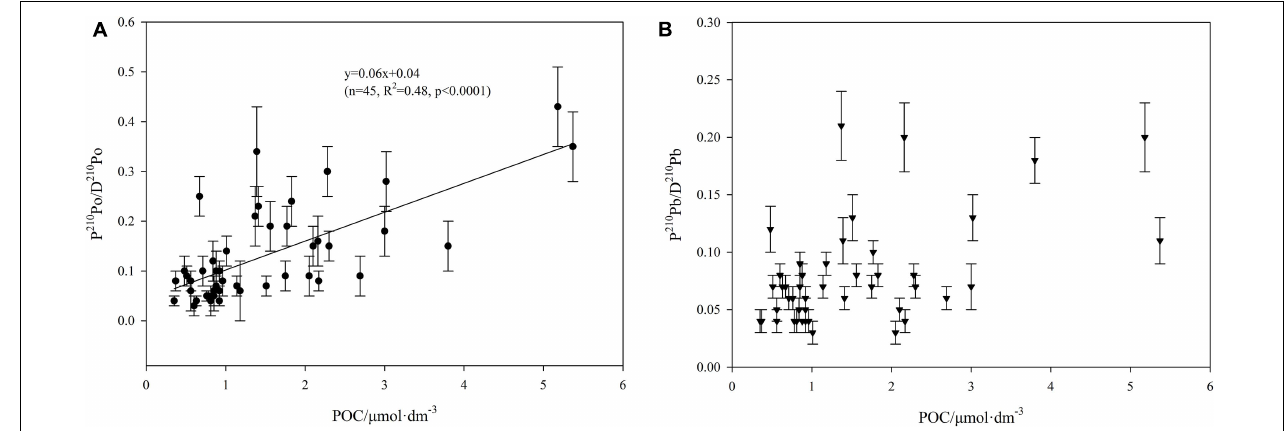
FIGURE 6 | The relationship between P 210 Po/D 210 Po ratio, P 210 Pb/D 210 Pb ratio, and POC concentration ( A : P 210 Po/D 210 Po ratio vs POC, B : P 210 Po/D 210 Po ratio vs POC).